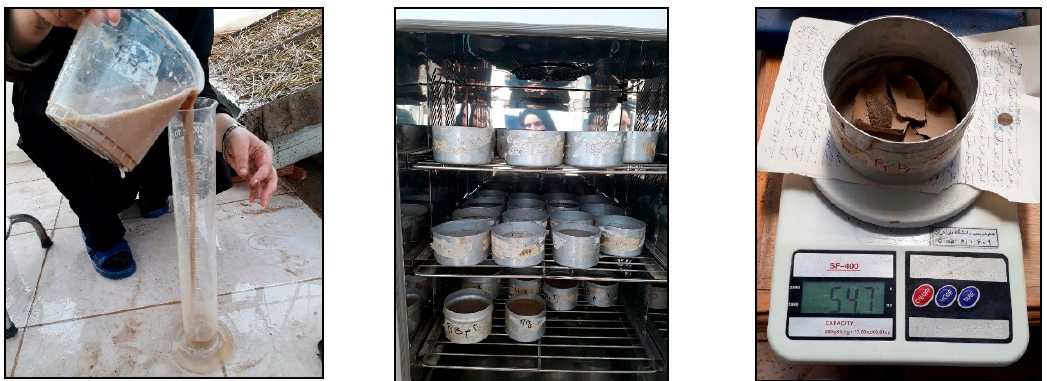
Figure 4. Laboratory measurements of runoff volume and soil loss.